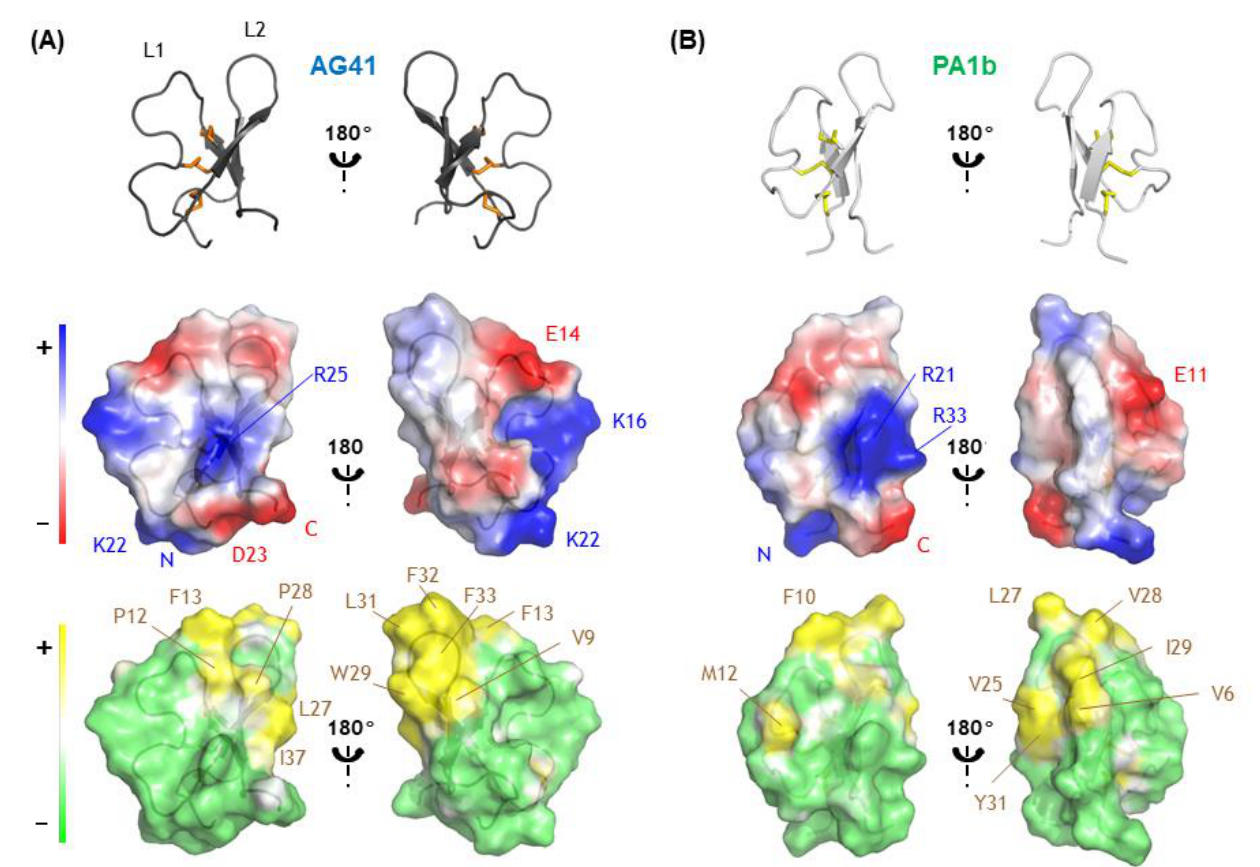
Figure 4. Electrostatic and lipophilic potentials calculated using the APBS plugin in PyMOL [28] and Platinum [36], respectively, at the molecular surfaces of ( A ) AG41, ( B ) PA1b. Rotating the left panel 180 ◦ around a vertical axis to match the right panel. Positive and negative areas as well as the residues defining these areas are shown in blue and red, respectively, while hydrophobic and hydrophilic areas are displayed in yellow and green, respectively. Residues involved in the definition of hydrophobic region are also indicated in brown.